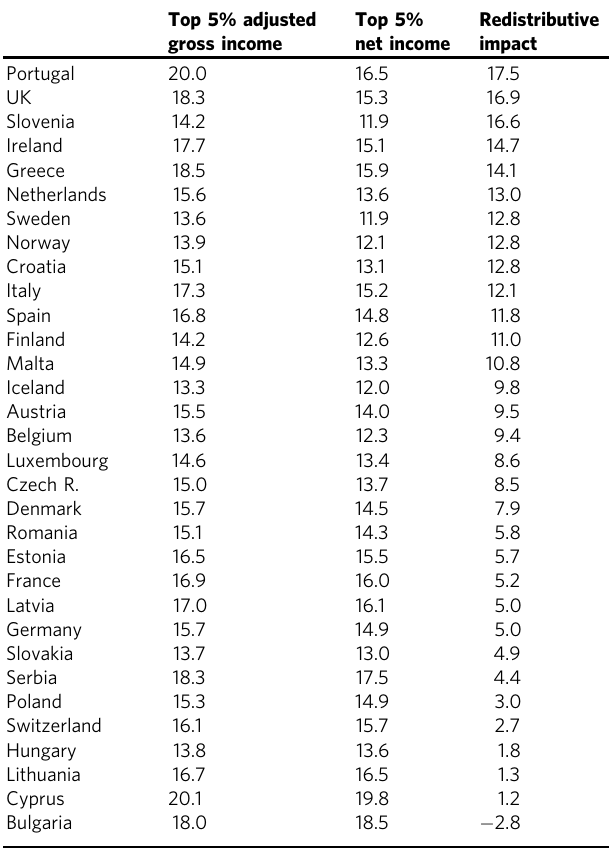
Table 3 Top 5% share of adjusted gross and net income, European countries (2013 – 2014)